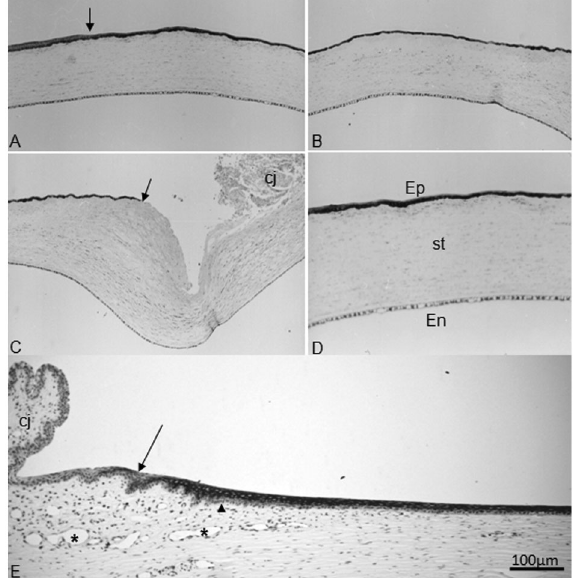
Figure 5. Low-power view of paraffin sections of a cornea immunostained with AE5 antibody without any counterstaining 36 h after scraping of the peripheral epithelium plus surgical excision of the limbus ( A - C ). In these sequences of photomicro- graphs, a very strong reaction is observed in the corneal epithelium (Ep). A , Part of the original epithelium can be identified to the left of the vertical arrow. The rest of the epithelial covering is made up by newly regenerated cells. B , Continuation of plate A toward the periphery. C , Epithelial covering ending at the valley caused by the resection of the limbal stroma (arrow). Part of the conjunctiva (cj) is seen on the right-hand side of the photomicro- graph. D , The control cornea with all of its layers; Ep: epithelium; st: stroma; En: endothelium. E , The cornea 3 months after the surgical procedure stained with the AE5 antibody plus counter- staining with hematoxylin. The oblique arrow points to the limbus. The arrowhead identifies the basal membrane; asterisks are in the lumen of limbal vessels. Part of the conjunctiva (cj) is seen on the left-hand side of the plate.